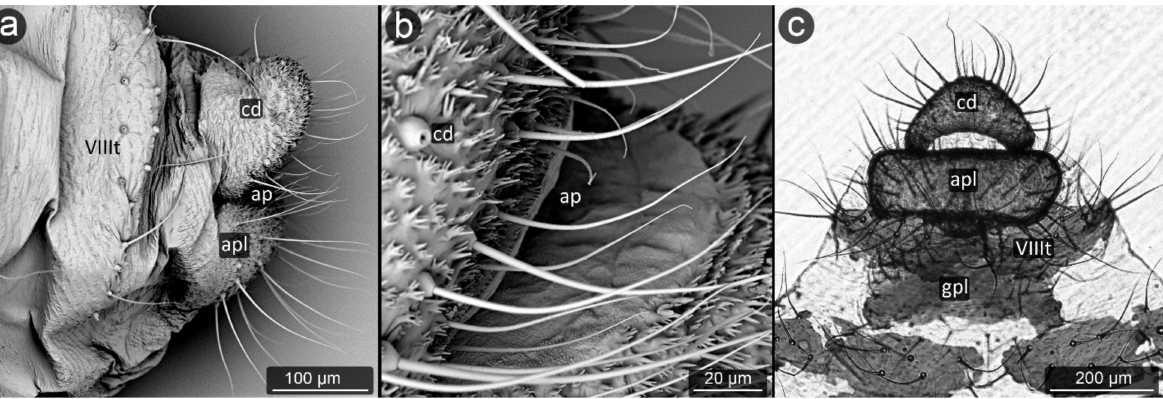
Figure 16. Perianal structure of Pterocomma konoi ; ( a )—lateral view (SEM), ( b )—close-up of anal pore and cauda (SEM), ( c )— rear view in light microscopy. Abdominal tergite VIII: with a very fine microsculpture, with setae arranged in two